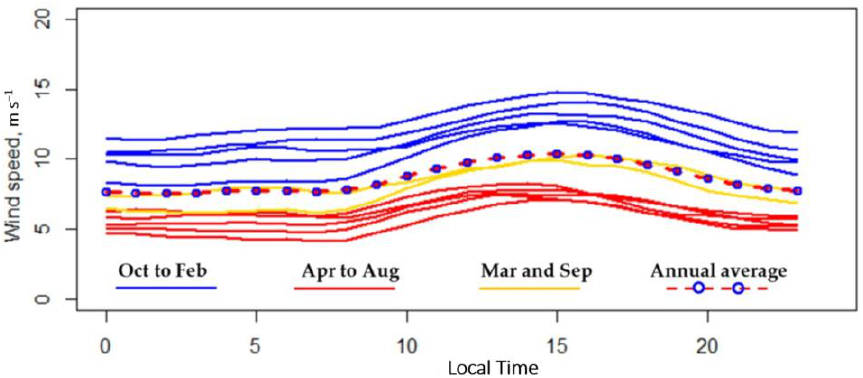
Figure 5. The wind speed diurnal variation patterns of individual months.